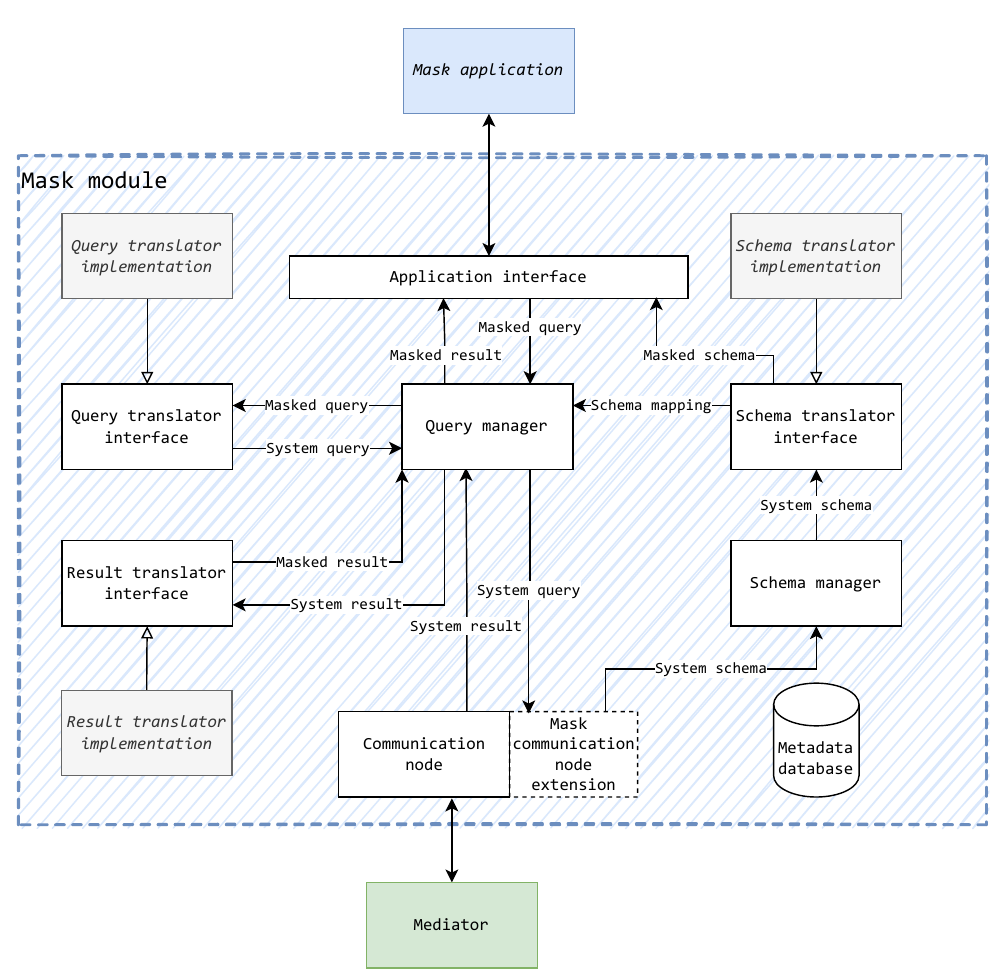
Figure 12. Conceptual component design of the mask